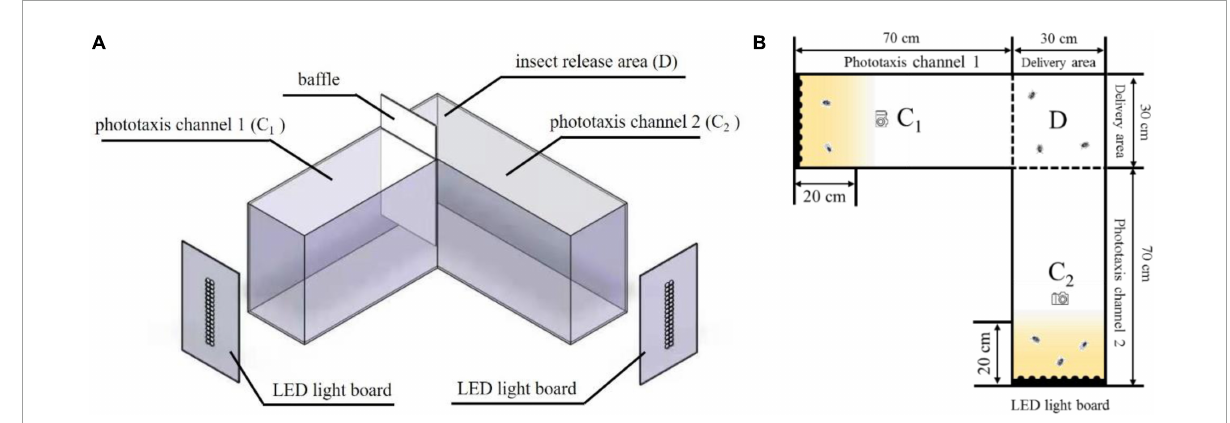
FIGURE2 Insect behavioral response box. C 1 , phototaxis channel 1; C 2 , phototaxis channel 2; D, insect release area. (A) Three-dimensional structure diagram, (B) Plane structure drawing.